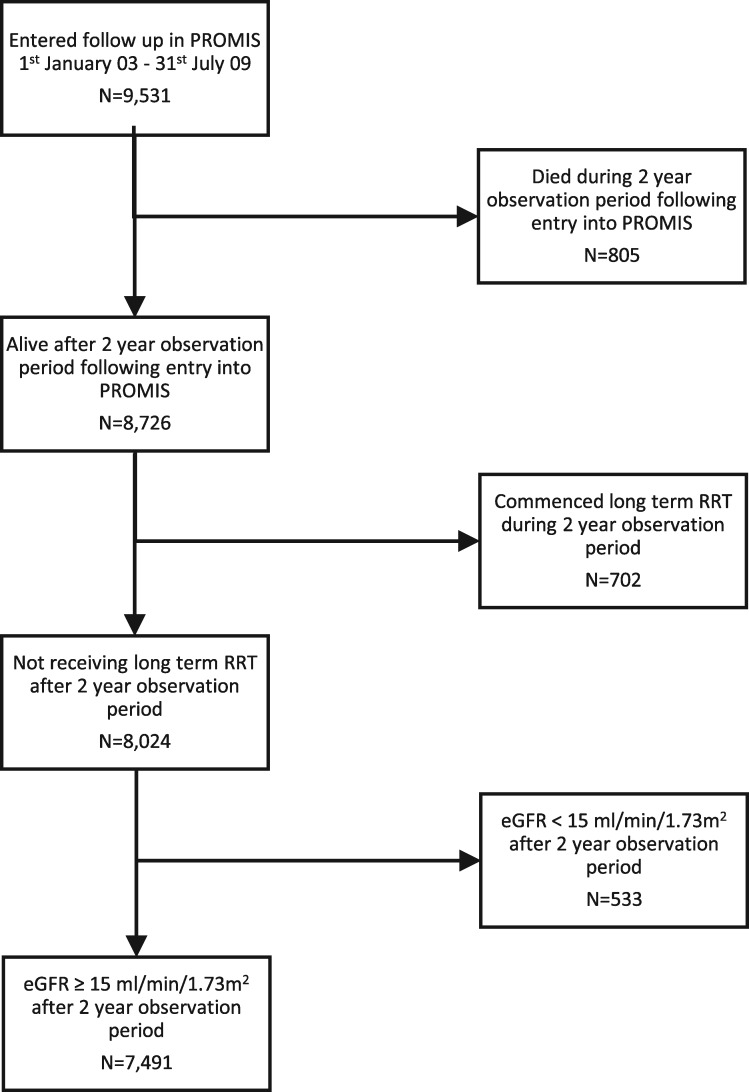
Development of the study population.